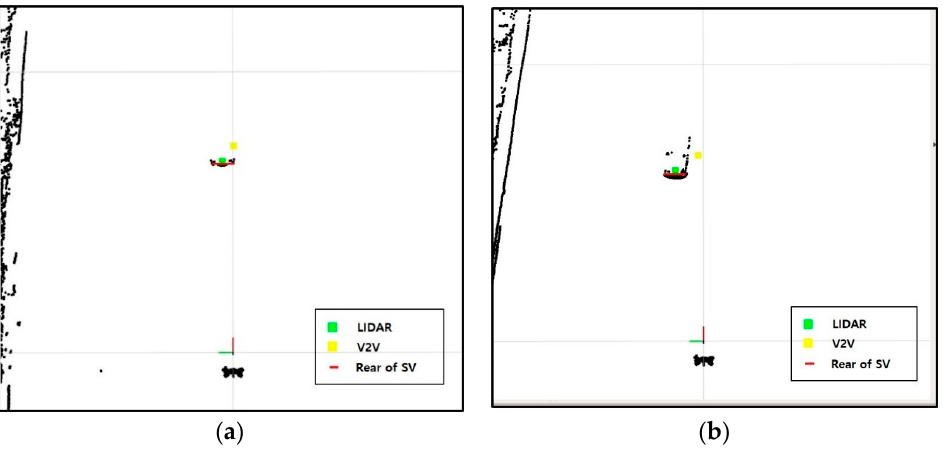
Figure 4. ( a ) In the case of keeping the lane in the same lane, Estimated location using V2V communications and LIDAR; ( b ) In the case of changing the lane in the adjacent lane, Estimated location using V2V communications and LIDAR.